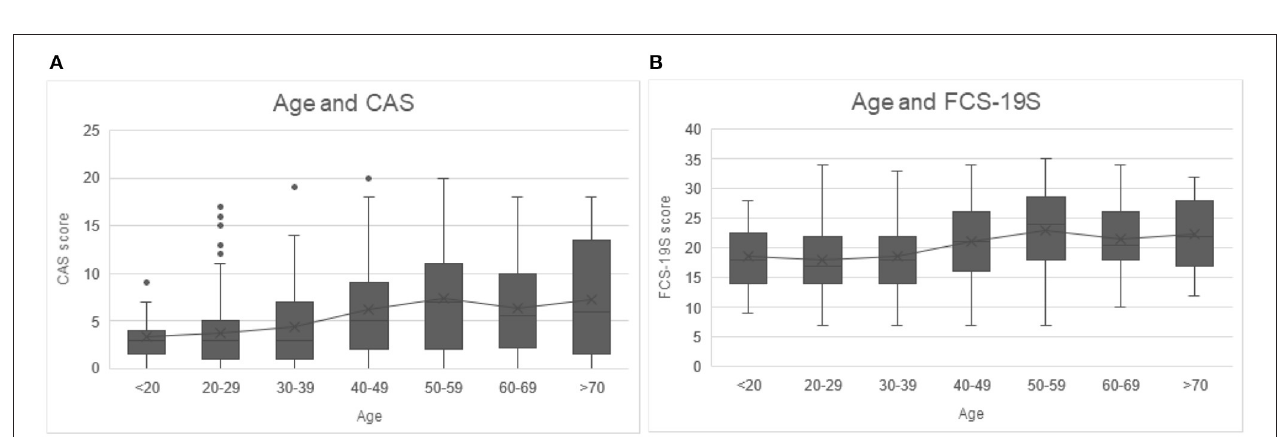
FIGURE 1 | (A) Correlation between CAS and FCS-19S scores; (B) correlation between CAS scores and FCS-19S scores in the female subgroup; and (C) correlation between CAS scores and FCS-19S scores in the male subgroup. CAS, Coronavirus Anxiety Scale; FCS-19S, Fear of COVID-19 Scale; COVID-19, coronavirus disease